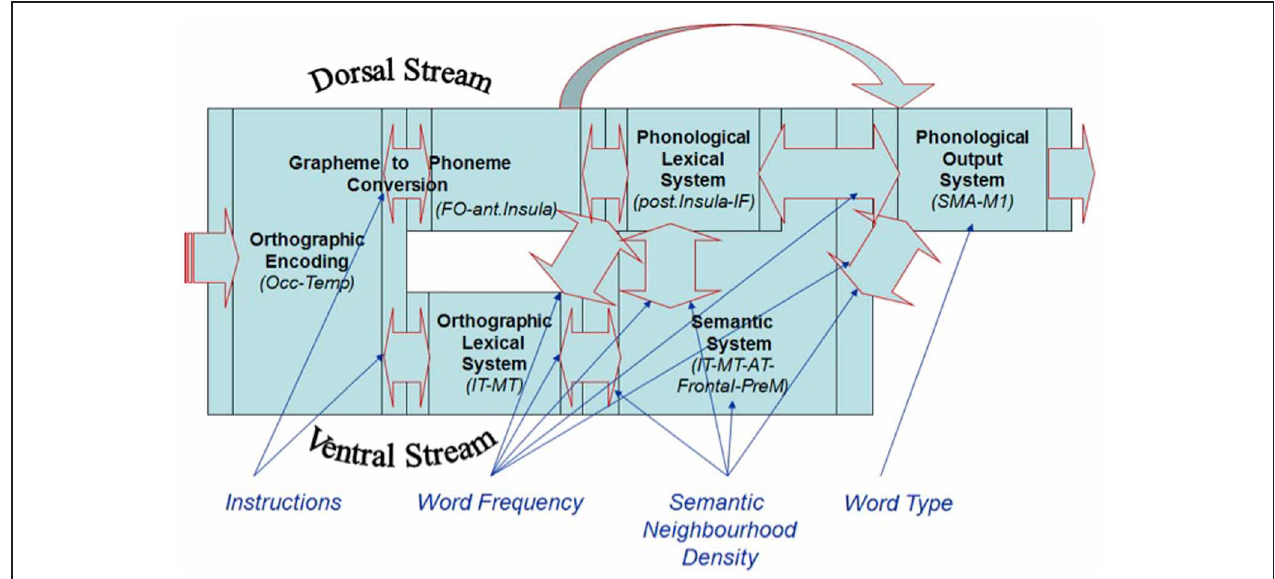
FIGURE 1 | A dual-stream, ventral-lexical, dorsal-sublexical, cascaded processing framework for basic reading processes.